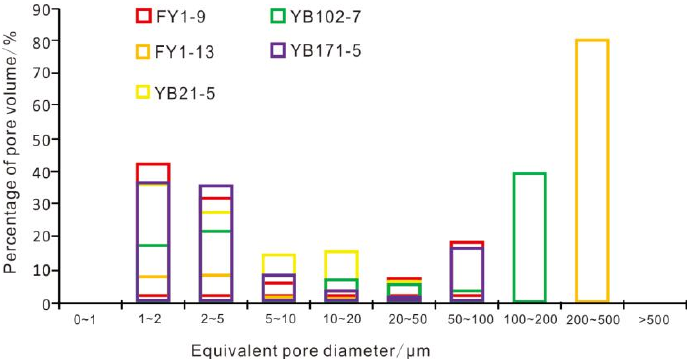
Figure 7. Percentage distribution of pore volume of different equivalent diameters of micron CT.